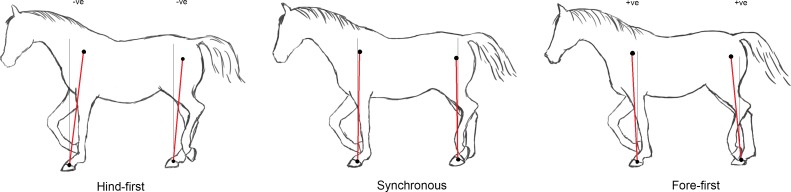
Illustration of mean limb postures for different dissociations during trotting.The sign of typical mean fore and hindlimb angles for hind-first and fore-first dissociations are shown with angles exaggerated to illustrate the different mean postures.